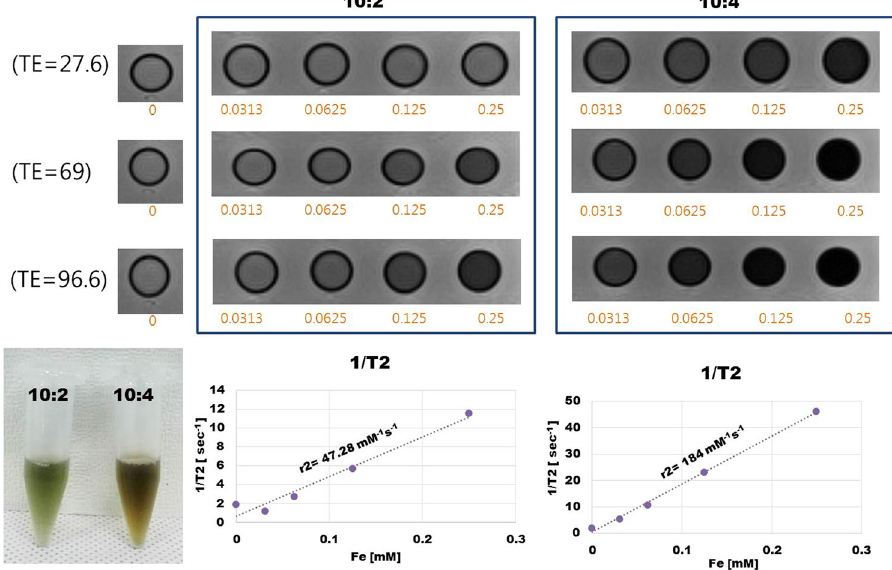
Figure 6. Relaxivity (r2 value) measurements of MHI-DSPE-SPION by linear correlation between the relaxation rate, 1/T2, and the concentration of iron for ratios of 10:2 and